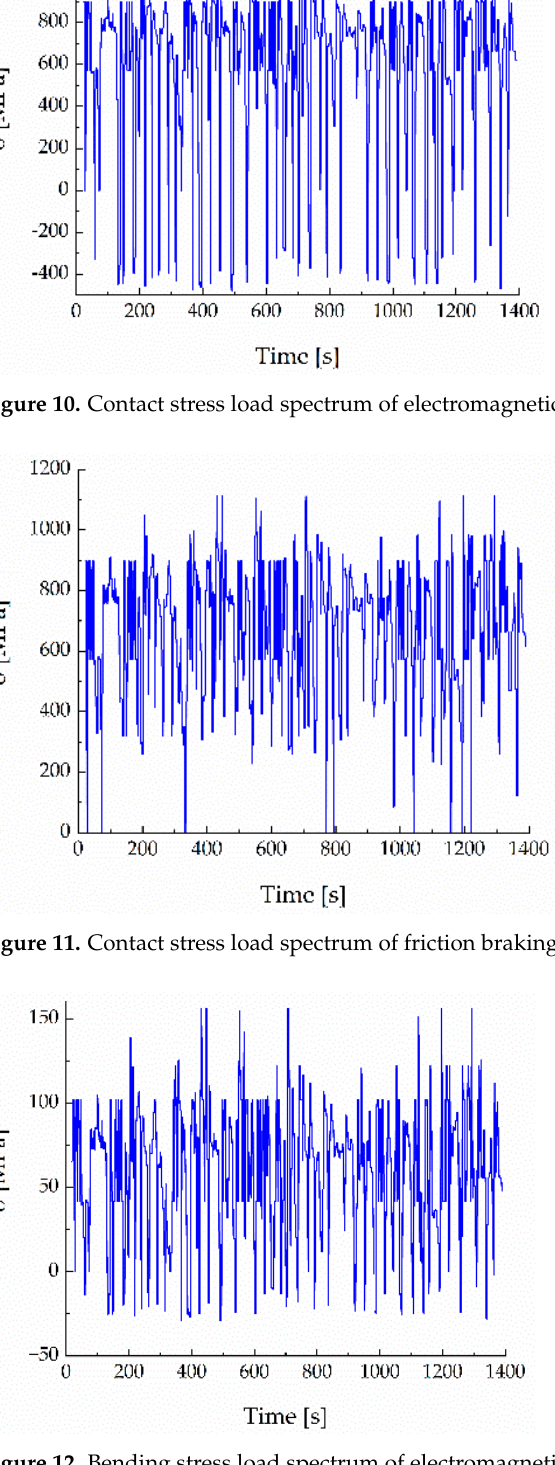
Figure 13. Load spectrum of friction braking bending stress.